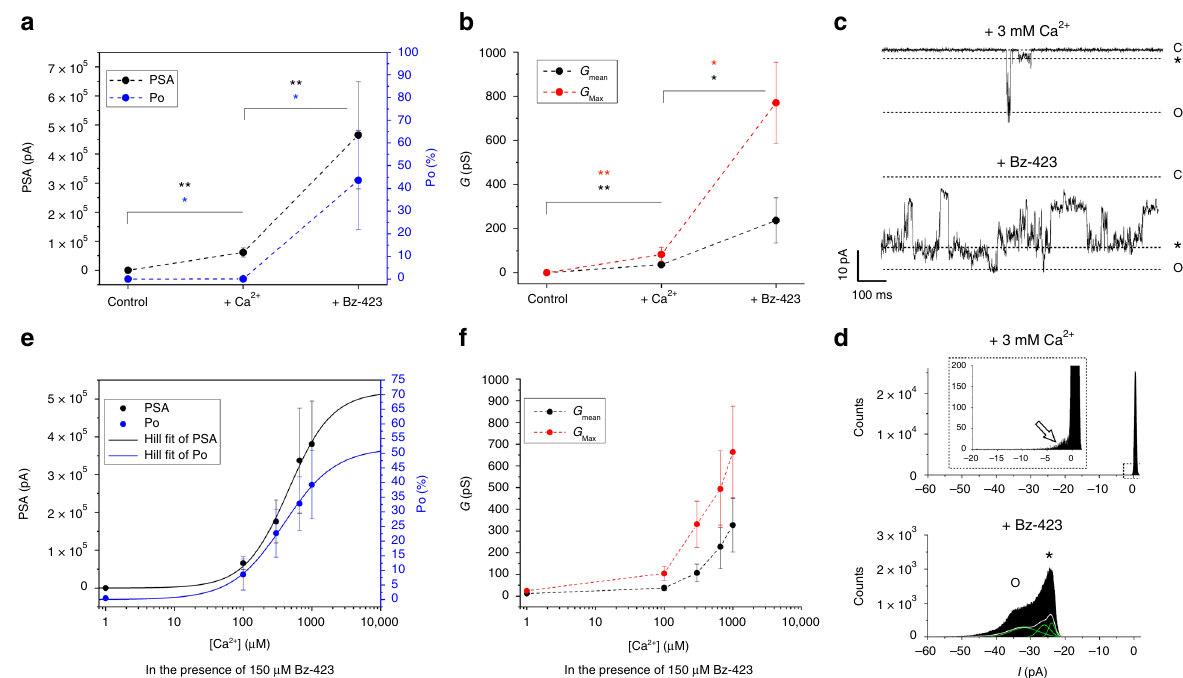
Fig. 5 Ca 2 + -dependence and activation of F-ATP synthase channels by Bz-423. a Power spectrum area (PSA) and open probability (Po) of F-ATP synthase channels were calculated from fi ve independent experiments in the absence of activators (control), after addition of 3 mM Ca 2 + alone or following the addition of both 3 mM Ca 2 + and 0.15 mM Bz-423. Zero values are indicated with black and blue dotted lines for PSA and Po, respectively. Data shown are mean ± SEM. Statistical signi fi cance of differences was assessed with the Mann – Whitney test (* p ≤ 0.05, ** p ≤ 0.01). b Mean and maximal conductance ( G mean and G max ) were calculated for the same experiments shown in panel a . c Current traces elicited after addition of 3 mM Ca 2 + alone or after further addition of 0.15 mM Bz-423 ( V cis = – 60 mV, G max = 500 pS) from one representative experiment of fi ve. The closed state is denoted with C, the most frequent subconductance state with an asterisk, and the maximal open state with O. d Current distribution of 30 s-recordings from experiments similar to the one reported in panel c . In the presence of Ca 2 + alone, fl ickering openings may be observed as a small peak in the histogram (arrow), while in the presence of Bz-423, a complex distribution with multiple peaks at higher conductance values (400 and 500 pS) is detectable. e PSA and Po of F-ATP synthase channels as a function of the Ca 2 + concentration in the presence of 0.15 mM Bz-423; PSA and Po distributions were fi tted with the Hill